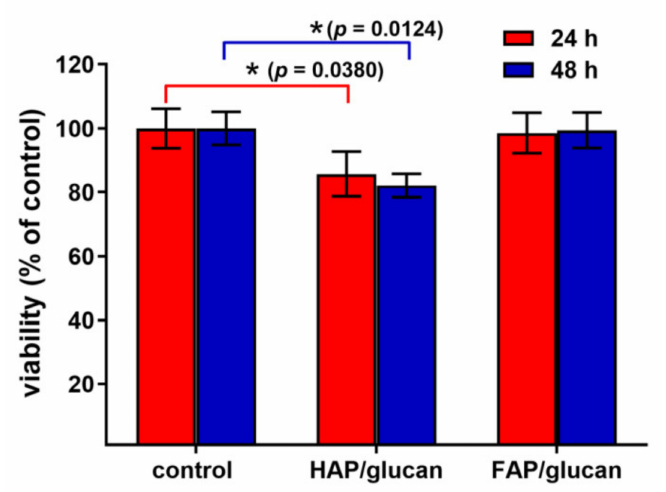
Figure 8. MTT cytotoxicity test performed for the biomaterials using human osteoblasts (hFOB 1.19 cell line) according to ISO 10993-5 standard (* statistically significant results according to unpaird Student’s t -test).